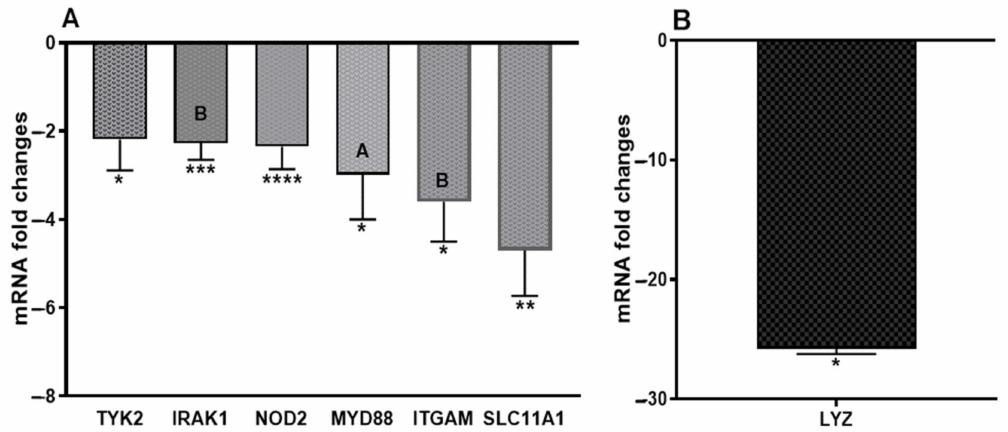
Figure 11. ( A ) TYK2, IRAK1, NOD2, MYD88, ITGAM, SLC11A1, and ( B ) LYZ and GATA3 mRNA fold-change following a 24 h co-culture of ST285 with monocytes ( n = 3), compared to control monocytes. The innate and adaptive RT 2 gene profiler arrays were used to determine changes in gene expression. The symbols represent the p -value for Tukey’s test (one-way ANOVA) where * p < 0.05, ** p < 0.04, *** p < 0.02, and **** p < 0.01.